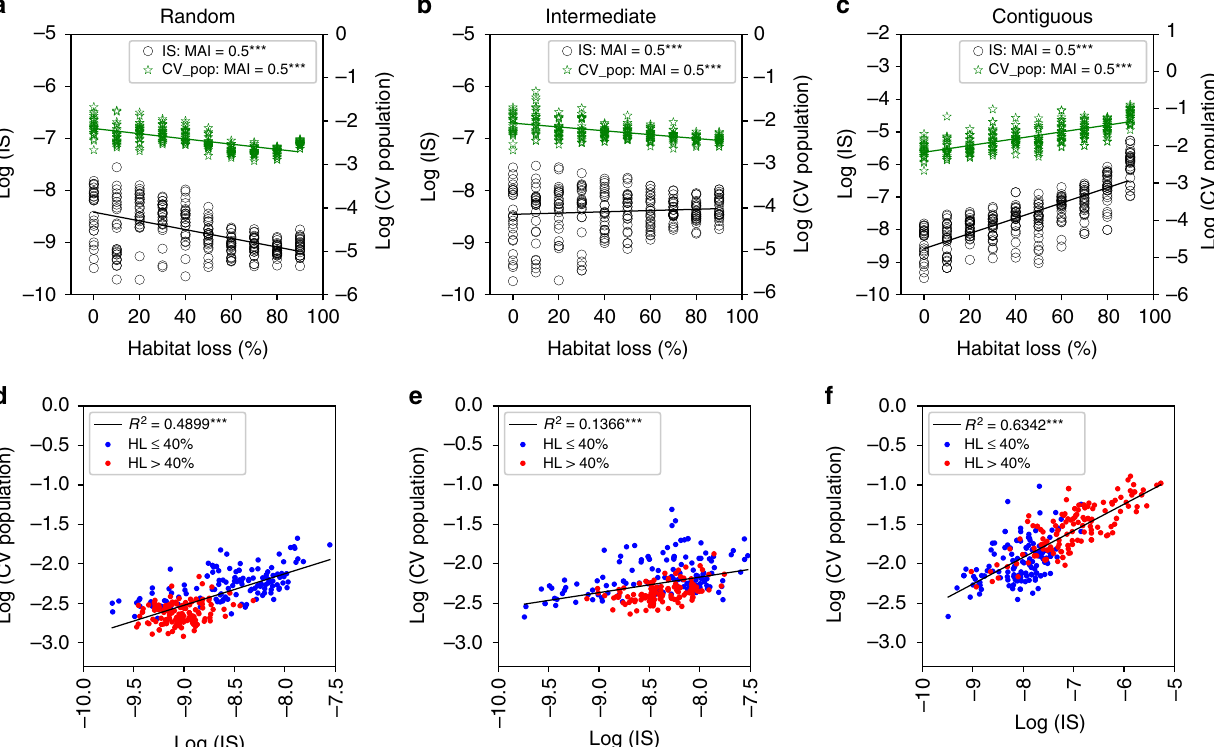
Fig. 3 Habitat loss, interaction strengths and temporal variability. Interactions strengths and temporal variability are natural log-transformed to linearize trends. a – c Mean interaction strength (IS) averaged over all interactions in realized network, and mean coef fi cient of variation in species abundances averaged over all species (CV population). d – f IS as a linear predictor for mean CV population, with low and high HL communities indicated by blue and red circle respectively. All communities for fractions of mutualism equal to 0.0, 0.5, 1.0 are shown (*** p -value < 0.05; F-test). a R 2 CV = 0.30, R 2 IS = 0.47; b R 2 CV = 0.33, R 2 IS = 0.007; c R 2 CV = 0.54, R 2 IS = 0.64